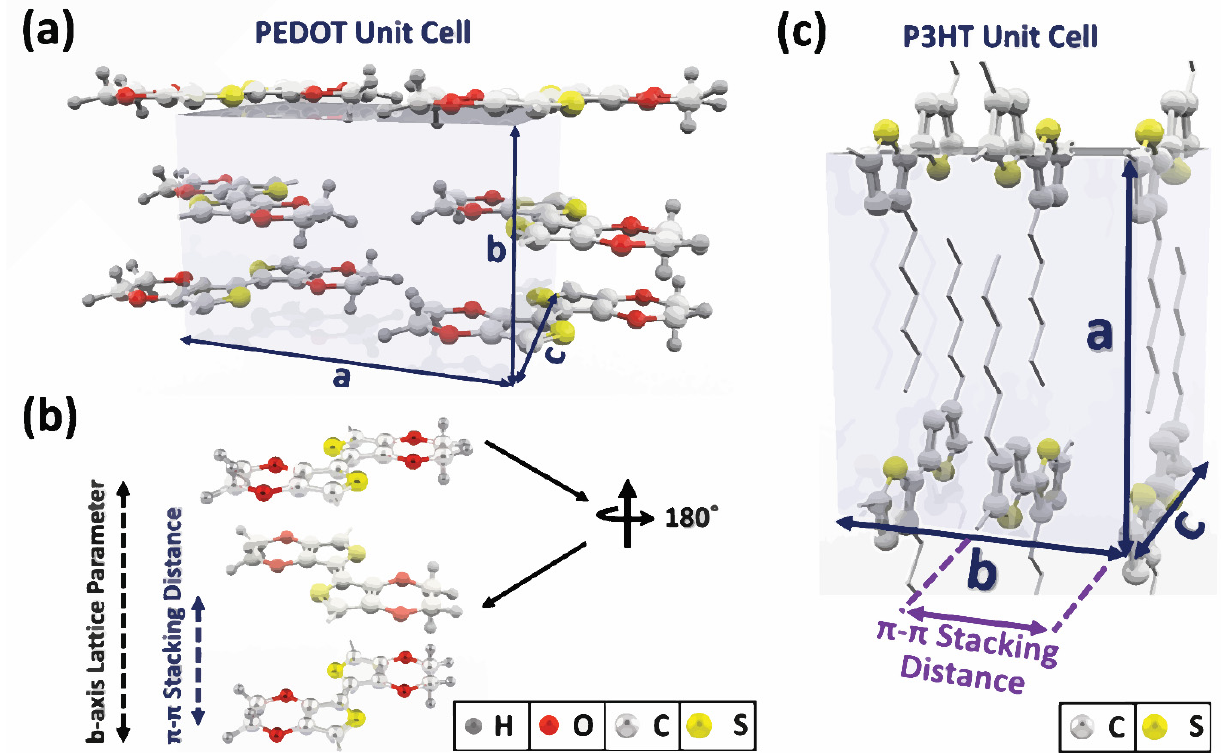
Figure 10. ( a ) Display of an orthorhombic PEDOT unit cell [18]. ( b ) Orientation of the polymer chain alternates by 180° along the backbone in order to obtain a minimum energy configuration of the